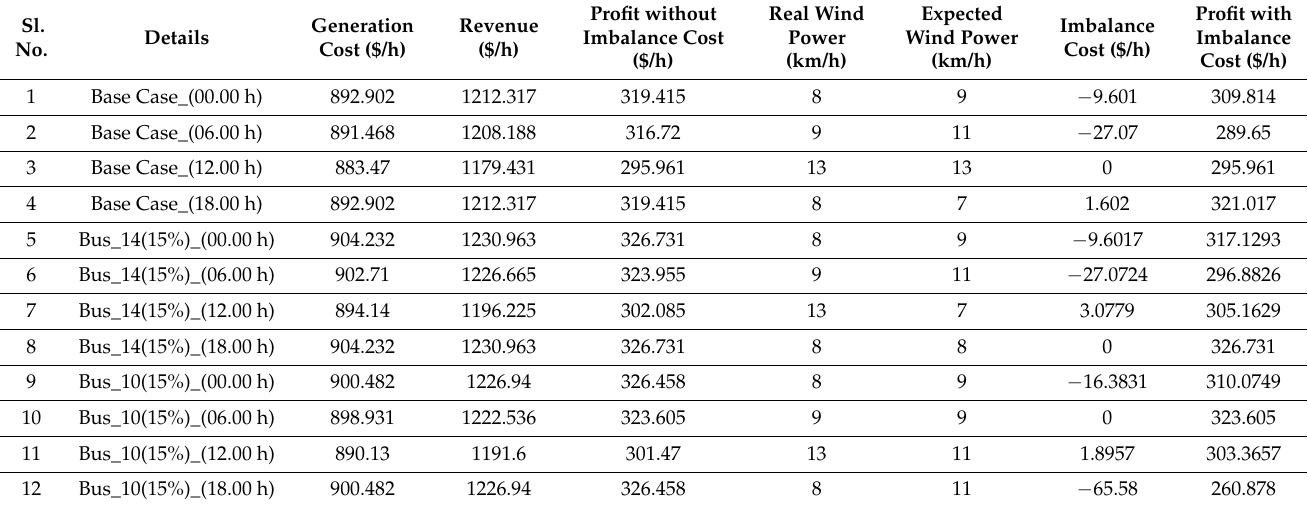
Table 5. Profit Comparison with Imbalance Cost (Kolhapur).